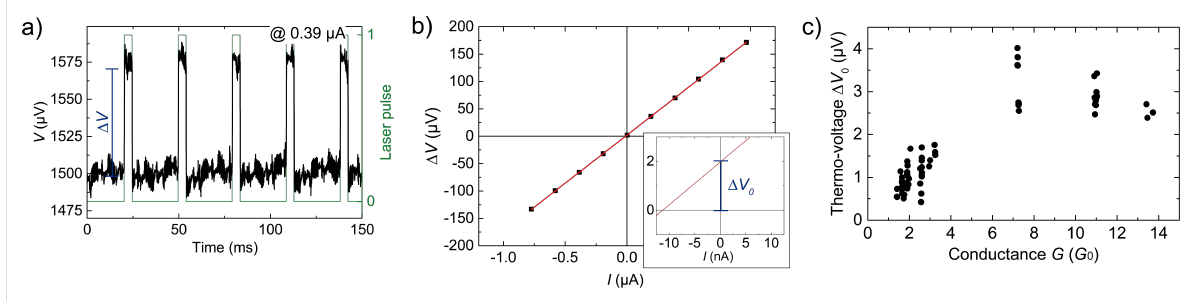
Figure 5: Measurement methodology of the main circuit for Au atomic-contacts at 77 K. a) Raw data of V versus time, at I = − 0.39 µA, during laser pulsing (green line). ∆ V is then be determined and averaged over many pulses at a specific I to achieve the ∆ V ( I ) curve plotted in b). The fitting (red line) with ∆ V = − 175.6 Ω · I + 2.07 µV yields ∆ V 0 = ∆ V ( I = 0) = (2.0 ± 0.3) µV (see blow-up).The error bars determined by statistical averaging over repeated pulses are smaller than the symbol size. c) Thermo-voltage ∆ V 0 versus the conductance of individual contacts. For these measurements,